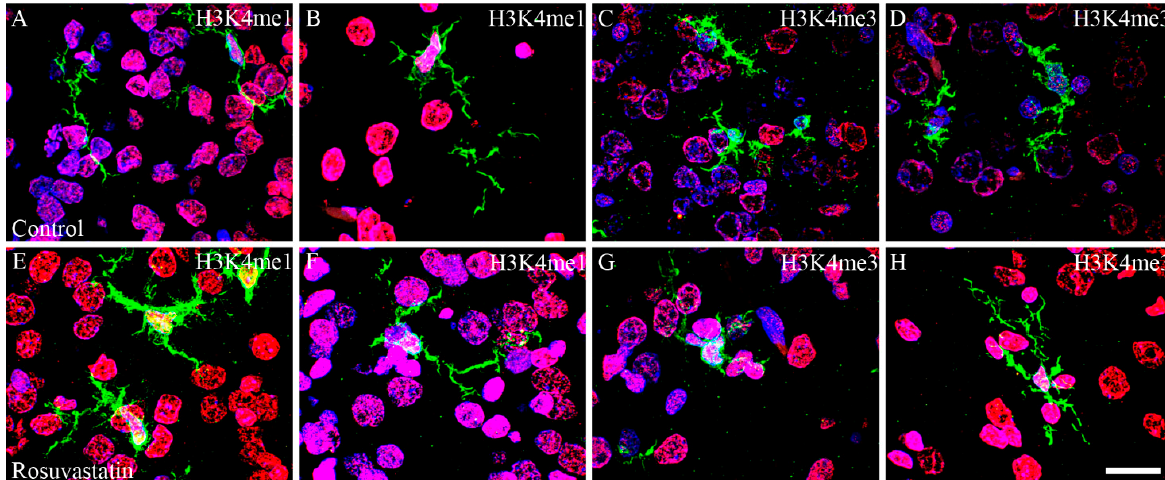
Figure 10. Laser confocal microscopy images of H3K4me1 and H3K4me3 immunoreactivities in microglial nuclei. Newborn brain sections from the control ( A – D ) and RST-treated rats ( E – H ) were immunostained for Iba1 (green), and H3K4me1 or H3K4me3 (red), then visualized by confocal microscopy. DAPI-labeled cell nuclei are blue. Note in the merged pictures the very few microglia that colocalize with the histone methylation marks. Scale bar: 20 µm.